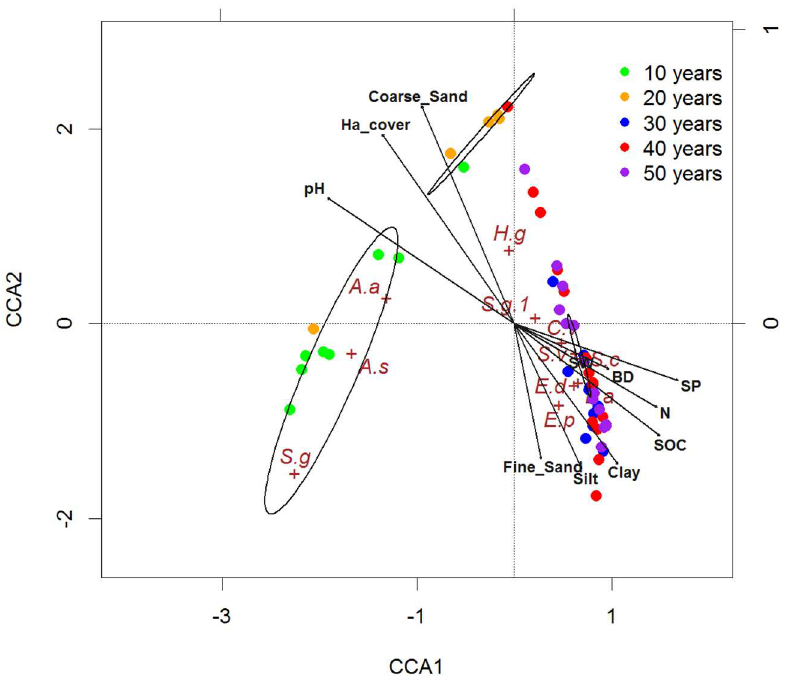
Fig 6. CCA ordination of plantation plots and native herbaceous distribution in relation to soil properties and coverageof H . ammodendron across 5 decades. (Circles show the plots and plus signs show the species’ relative abundance; A . s , Agriophyllum squarrosum; A . a , Artemisia arenaria;C . v , Chloris virgate; S . v , Setaria viridis; S . c , Salsolacollina; E . d , Echinopilon divaricatum; E . p , Eragrostispilosa ; H . g , Halogetonglomeratus ; S . g , Stipa glareosa ; L . a , Limonium aureum